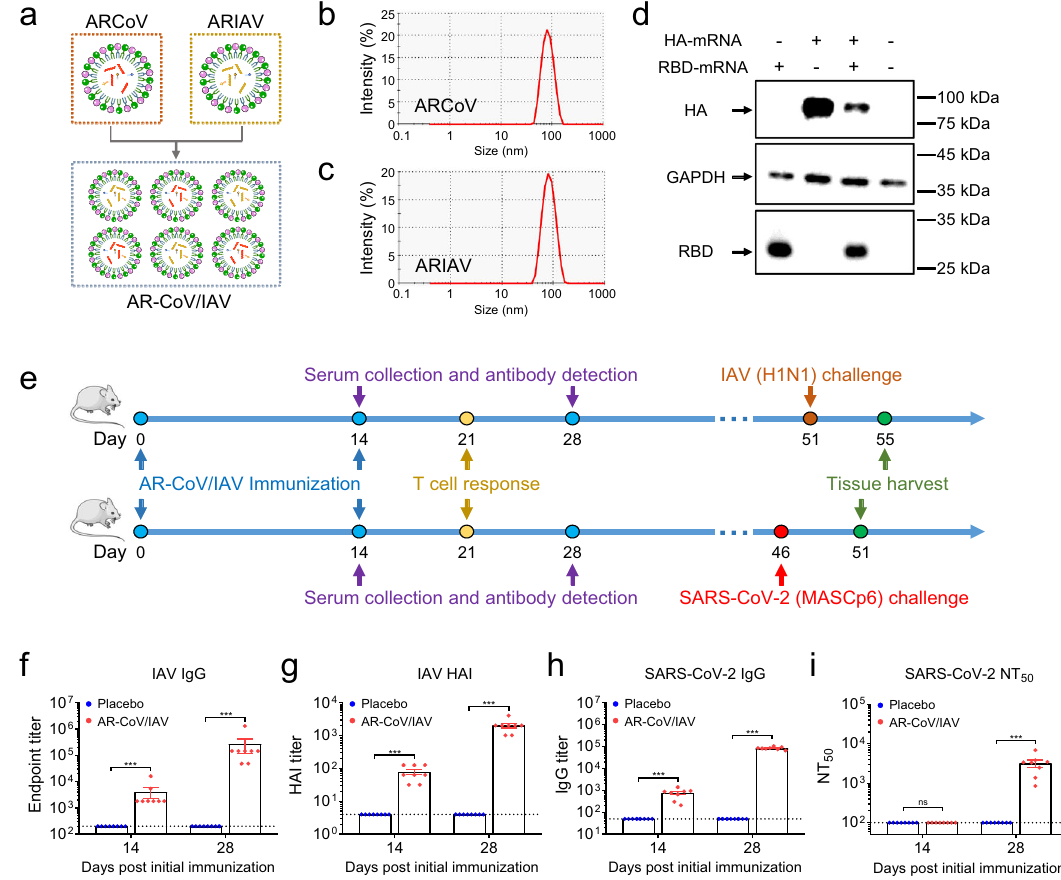
Fig. 2 AR-CoV/IAV immunization elicits a humoral immune response in BALB/c mice. a Schematic diagram of the AR-CoV/IAV formulation as a combination of ARCoV and ARIAV. b , c Representative intensity-size graphs of ARCoV and ARIAV. d HA and RBD protein expression in HEK293T cells was determined by immunoblotting. e Schematic diagram of the experimental design. Groups of mice were immunized with 30 µg of AR-CoV/IAV and boosted with the same dose after two weeks. Serum samples were collected 14 and 28 days post-initial immunization and subjected to antibody detection before an IAV or SARS-CoV-2 challenge. f , h IAV-HA- and SARS-CoV-2-RBD-speci fi c IgG antibody titers were determined by ELISA. g HAI titers were determined 14 and 28 days post-initial immunization. i NT 50 titers against SARS- CoV-2 were determined by using VSV-based pseudovirus. Data are shown as the mean ± SEM ( n = 8). Statistical differences were analyzed by using two-tailed unpaired t tests. *** P <